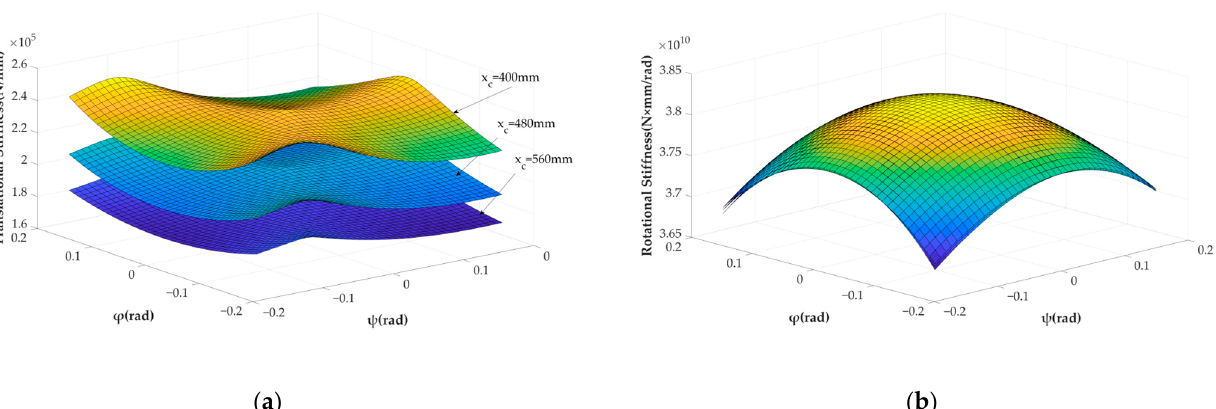
Figure 16. ( a ) The translational stiffness of the PM; ( b ) The rotational stiffness of the PM.